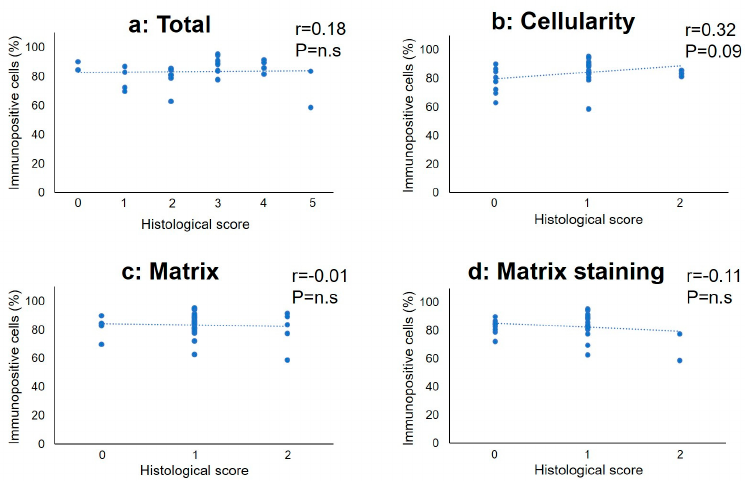
Figure 10. Correlation between the percentage of immunopositive cells for CAPRIN1 and histological score in the total ( a ), cellularity ( b ), matrix ( c ), and ( d ) matrix staining score. r: correlation effi- cient.